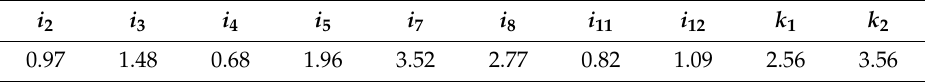
Table 3. Transmission ratio of the gear pair used in the simulation.